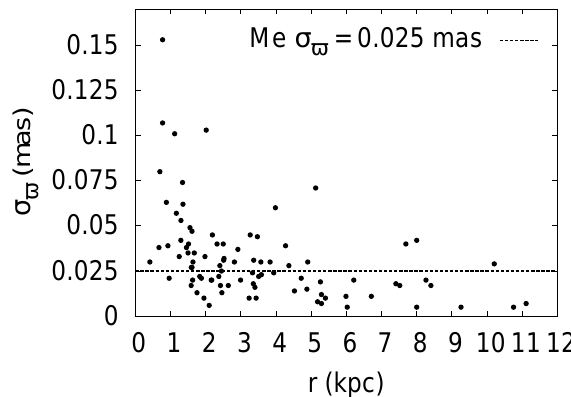
Fig. 5. Dependence of absolute parallax error on the heliocentric distance to the